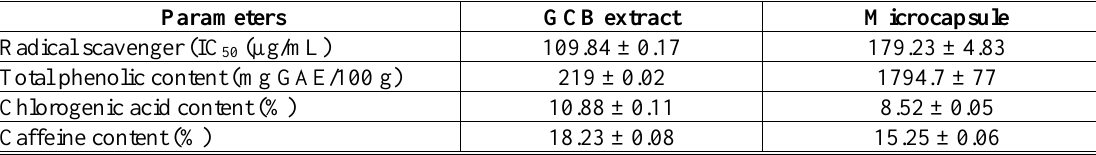
Table 2. Parameter values of the extract and the microcapsule